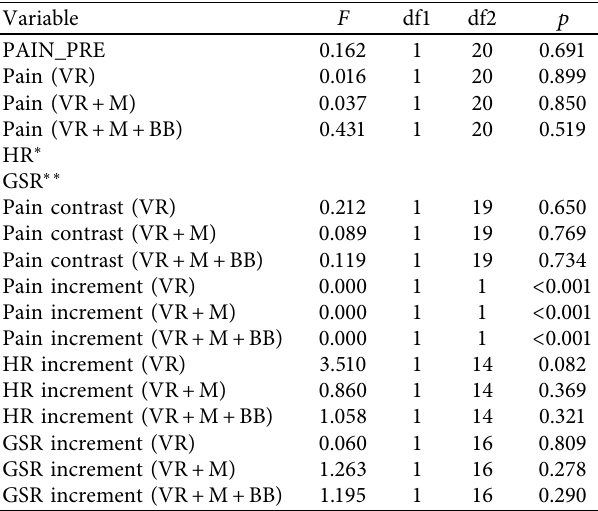
Table 4: Homogeneity of variances and sphericity